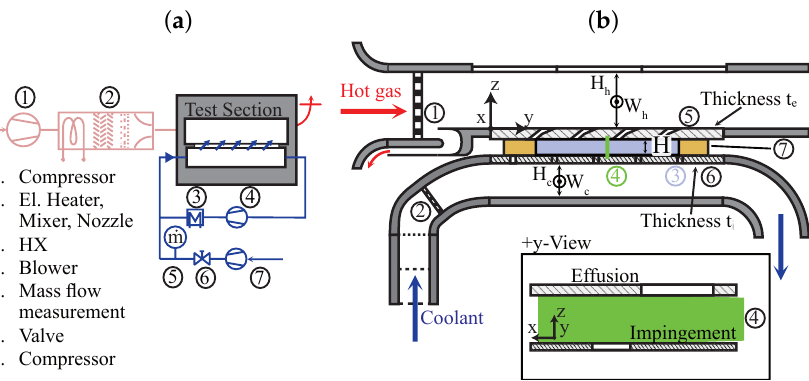
Figure 2. Test facility at ITS showing the hot gas path in red and the coolant path in blue. ( a ) In- frastructure (with object labels), ( b ) test section with 1 (cid:13) turbulence grid 2 (cid:13) meshes, screens and turbulence grid 3 (cid:13) glass frame inset 4 (cid:13) light sheet 5 (cid:13) specimen with effusion cooling pattern 6 (cid:13) specimen with impingement cooling pattern 7 (cid:13) PEEK frame around